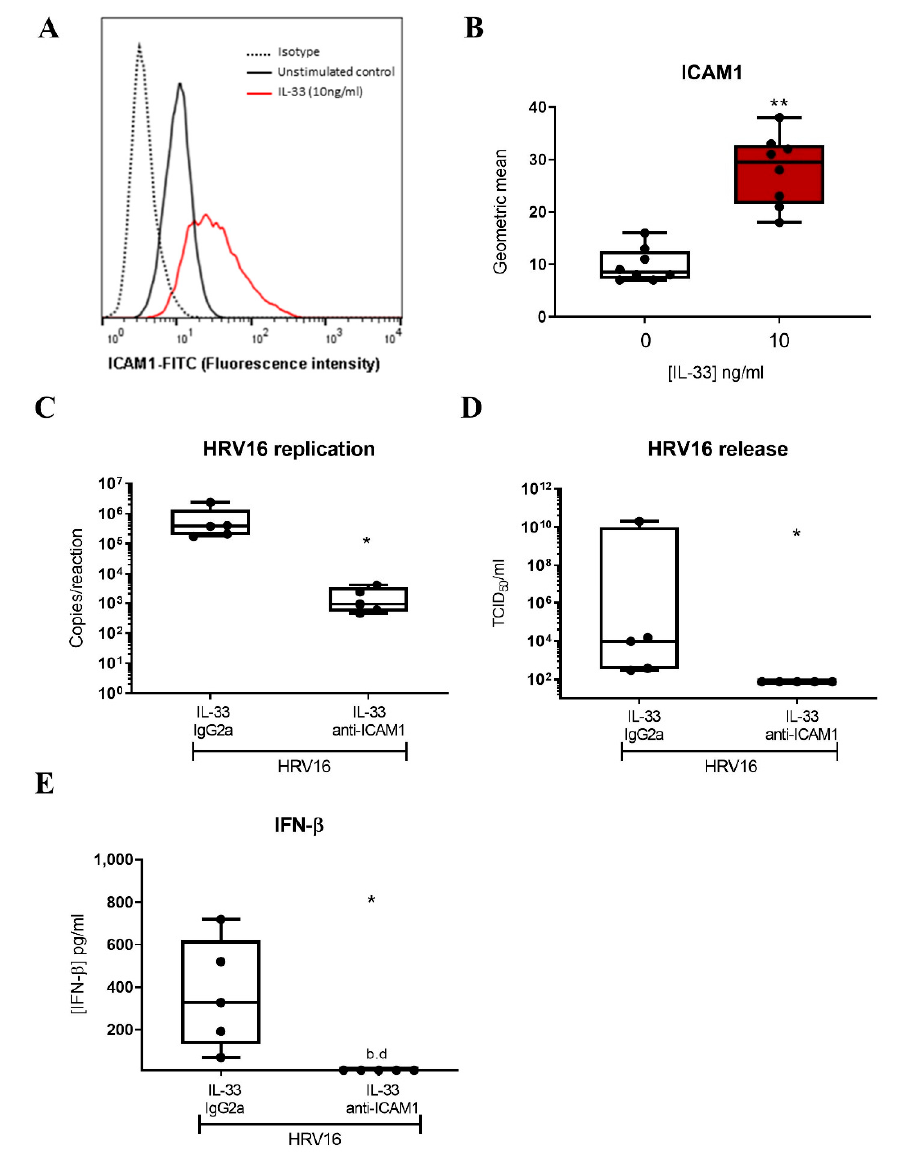
Figure 5. Role of ICAM1 in mediating IL-33-dependent enhancement of HRV16 replication in LAD2 MCs. A representative flow cytometric trace ( A ) and averaged geometric mean ( B ) for ICAM1 cell surface expression in MCs treated with IL-33 (10 ng/mL) for 24 h, n = 8. HRV16 replication ( C ) and virion release ( D ) and IFN- β protein release ( E ) following IL-33 (10 ng/mL) stimulation for 24 h prior to HRV16 infection (MOI 7.5) in the presence or absence of anti-ICAM1 antibody or IgG2a isotype for a further 24 h, n = 5. ** p ≤ 0.01 for no cytokine versus IL-33 and * p ≤ 0.05 for IL-33 IgG2a+HRV16 versus IL-33 anti-ICAM1+HRV16.